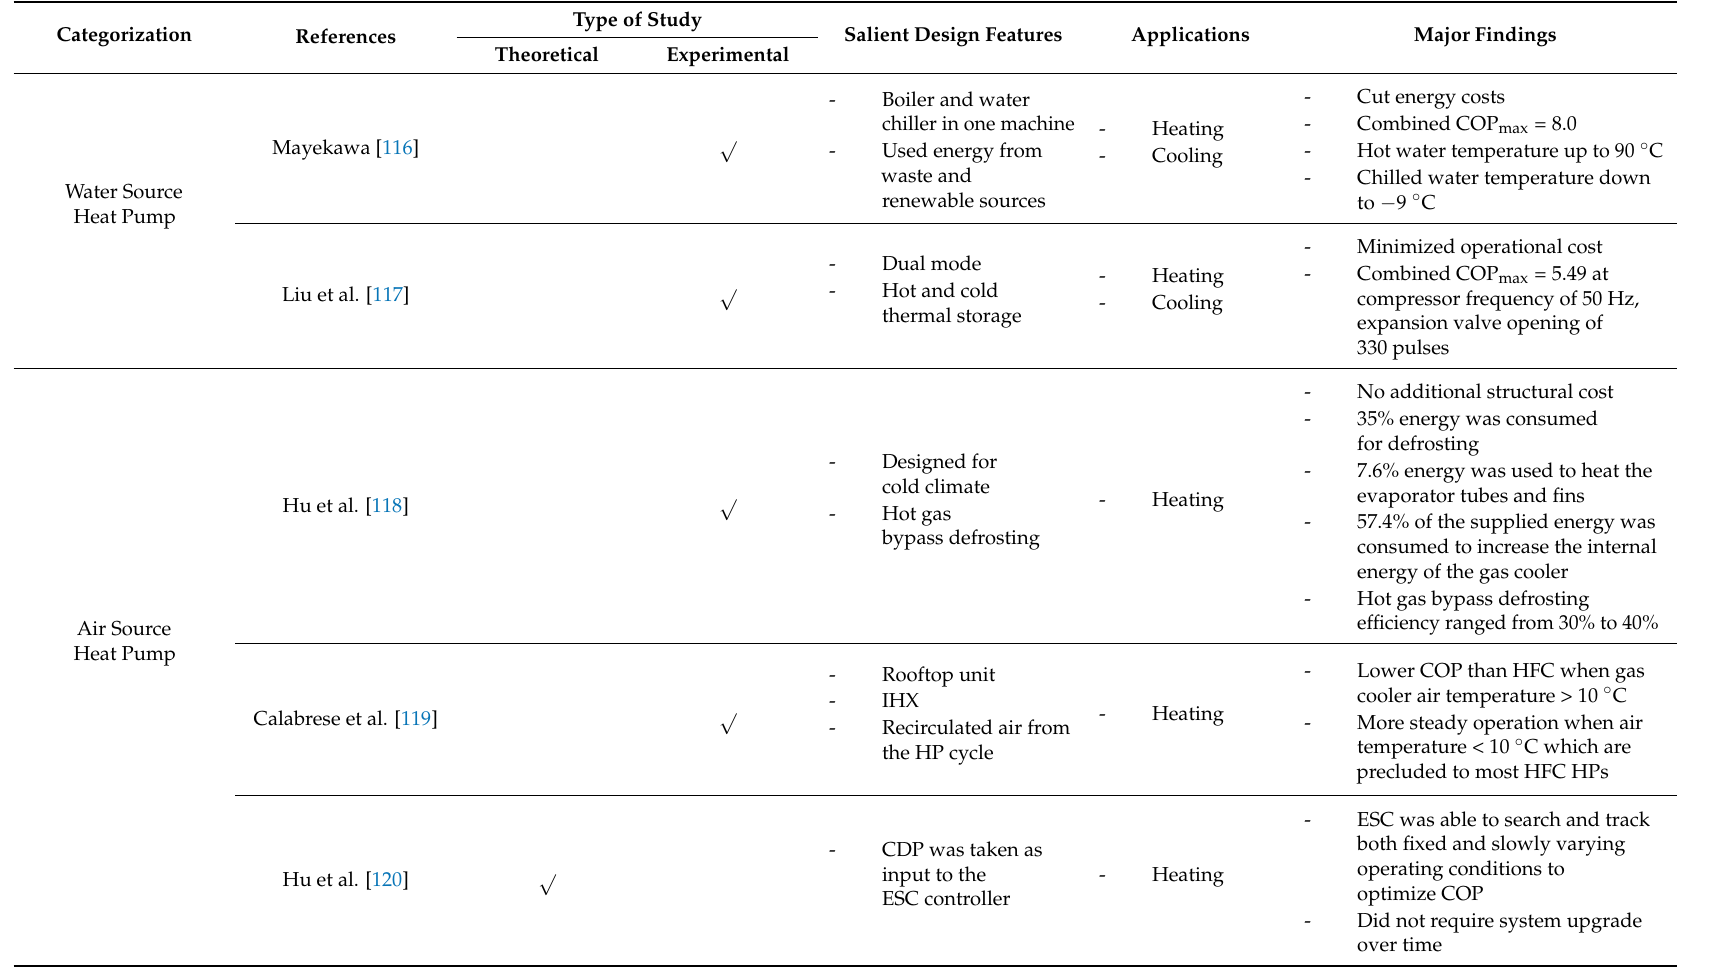
Table 3. A summary of studies conducted on CO 2 heat pump